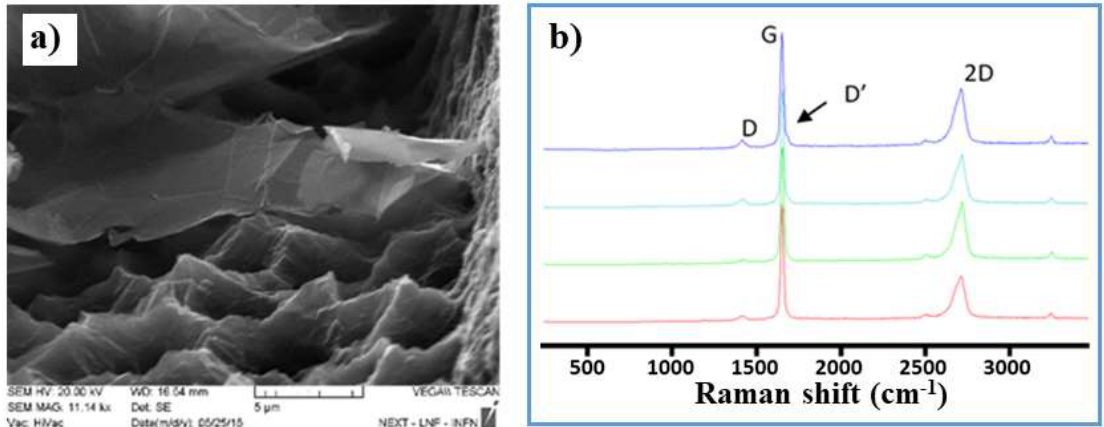
Figure 1. Structural characterization of the graphene nanoplatelets: ( a ) a SEM micrograph of GNP flakes; ( b ) Raman spectroscopy results.